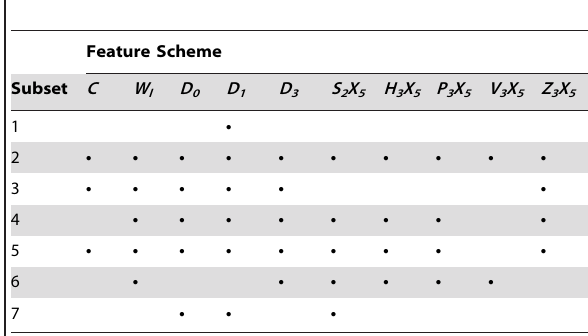
Table 4. The feature schemes that enabled the recognition of the AFP in a subset when single SVM classifier was